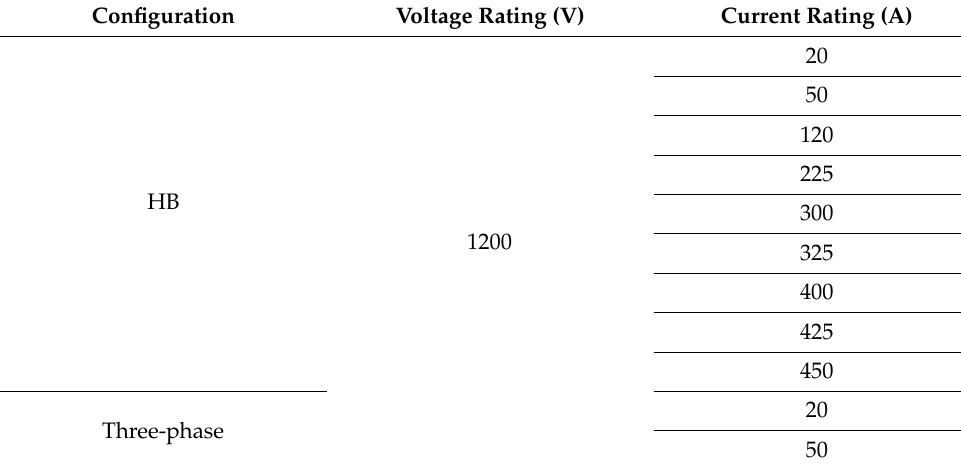
Table 15. Commercial SiC MOSFET modules by Cree.